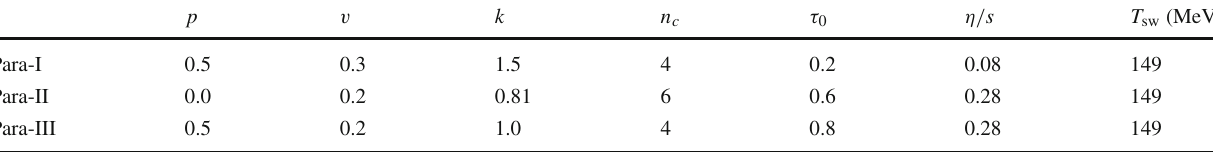
Table 3 Three parameter sets of iEBE-VISHNU simulations with TRENTo initial condition for p–p collisions at